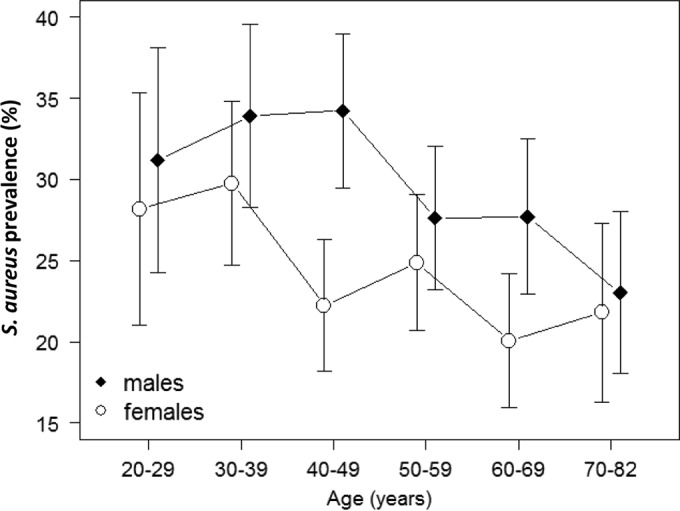
Mean prevalences (error bars show 95% confidence interval) of S. aureus nasal colonization according to age and gender.